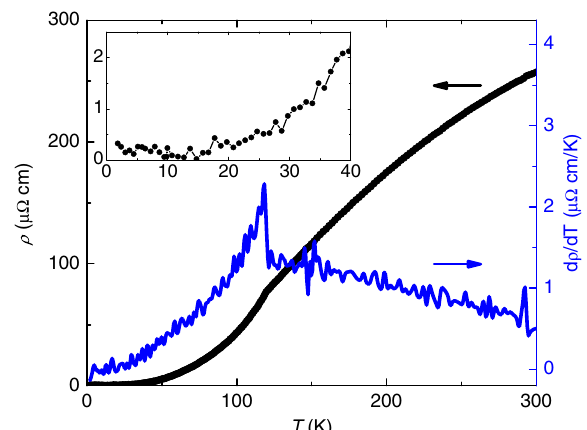
Fig. 1 Temperature dependence of the resistivity of FeP. The electrical resistivity (black, left axis) and its derivative (blue, right axis) as a function of temperature for an FeP crystal with a residual resistance ratio of 1000 and B = 0 T. The kink in the resistivity and jump in the derivative at 120 K correspond to the Neel temperature. The inset zooms in on the low temperature resistivity, highlighting the plateau below 20 K and value of residual resistivity of about 0.2 μΩ cm.